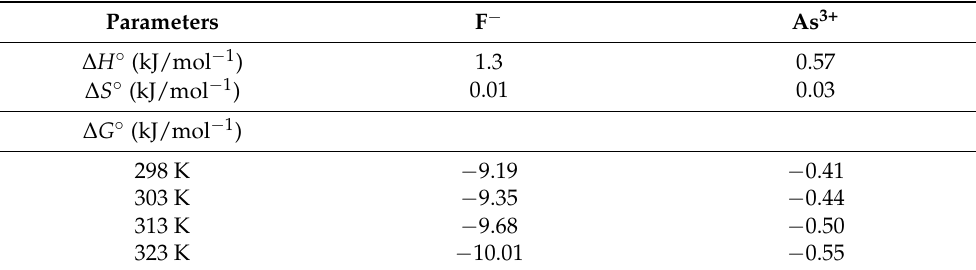
Table 7. Thermodynamic parameters of F − and As 3+ onto the Fe-pPD composite.